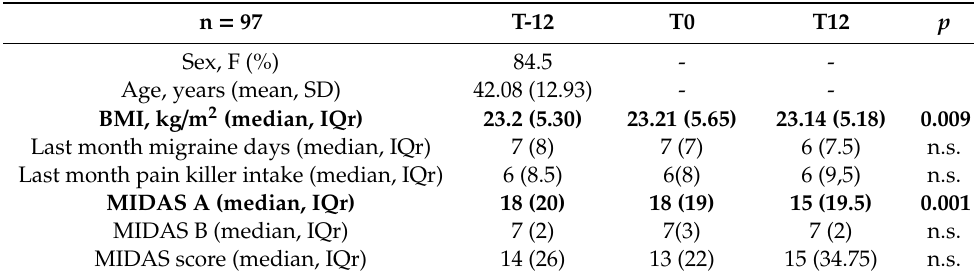
Table 2. Demographic, anthropometric measures, and migraine disability scales.